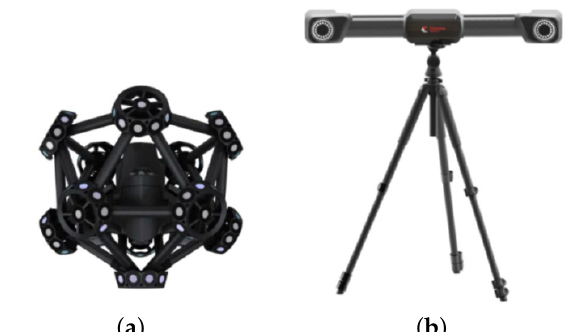
Figure 3. The physical map of the product. ( a ) The Metra SCAN 3D laser scanner. ( b ) The C-Track optical